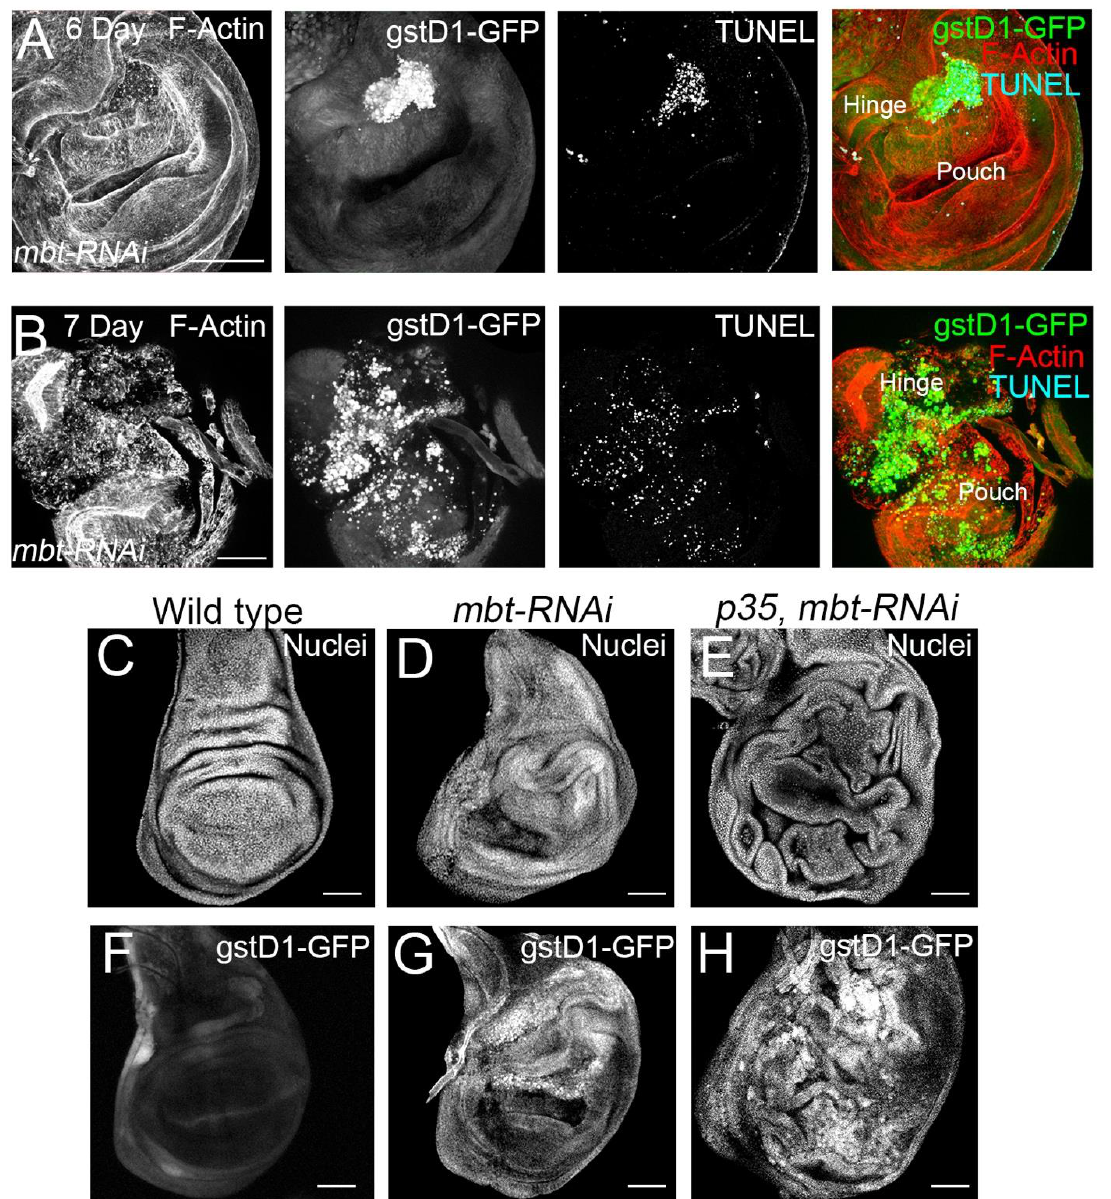
Figure 4. Apoptosis and ROS production in mbt-RNAi wing discs. ( A , B ) Wing disc from mbt-RNAi mutant larvae of 6 dAEL ( A ) and 7 dAEL ( B ). Expression of gstD1-GFP is shown in green, apoptosis is revealed by TUNEL (blue), and F-actin is stained with Phalloidin (red). Note the increase in severity of the overgrowths and extension and intensity of gstD1-GFP signal. ( C – H ) Wing discs stained with TOPRO (Nuclei; C – E ) and showing gstD1-GFP expression ( F – H ) from wild-type ( C , F ), mbt-RNAi ( D , G ), and mbt-RNAi co-expressing p35 larvae ( E , H ). Co-expression of p35 enhances the overgrowths and gstD1-GFP is still present. Scale bars: 50 µm .